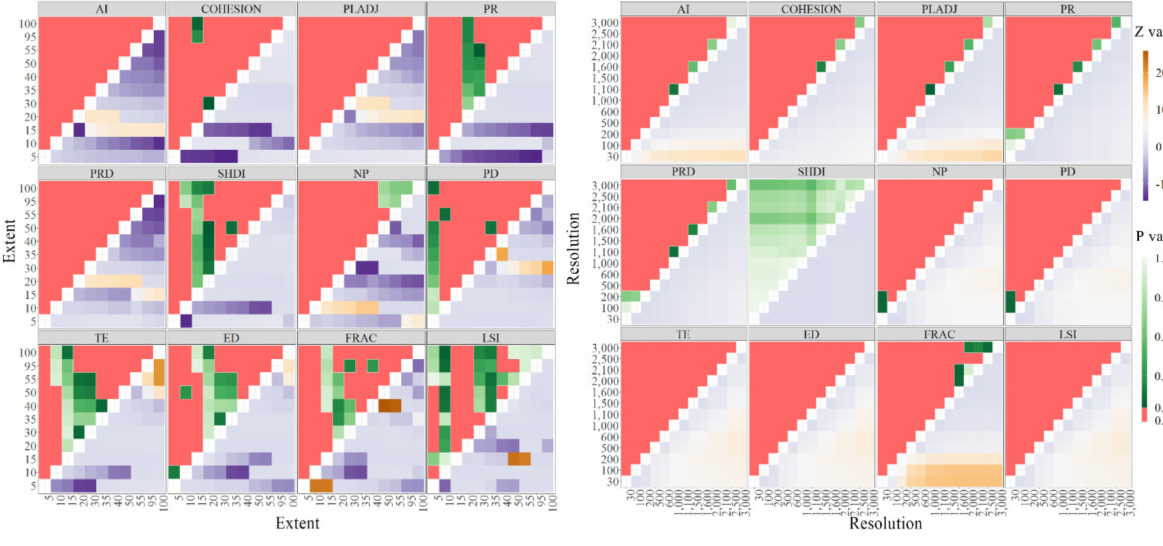
Figure A4. The double matrix figure of the Z